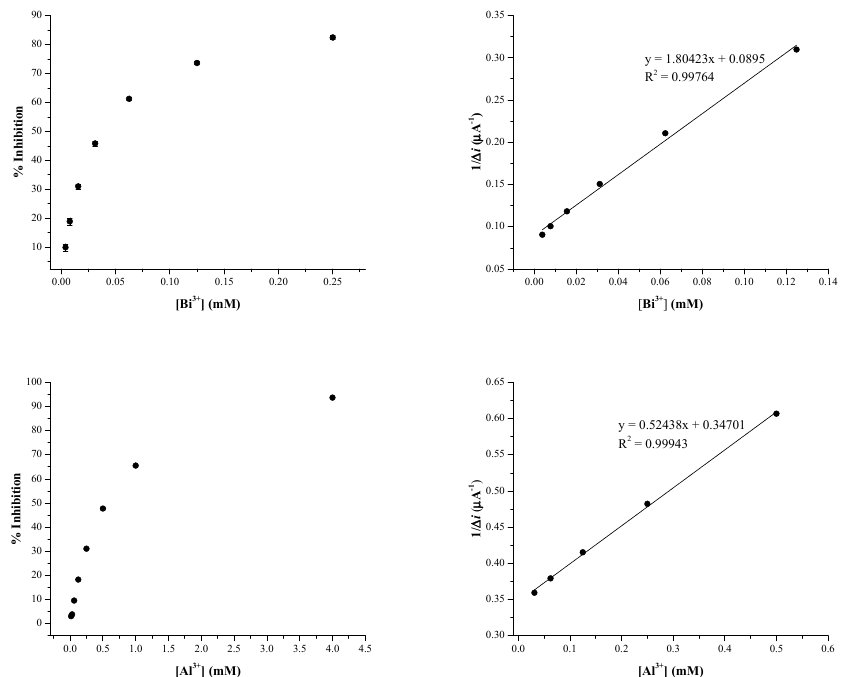
Figure 3. Inhibitive effects and Dixon plot for Pt/PPD/GOx biosensor after the injection of different concentration of Bi 3+ and Al 3+ ions in presence of 20 mM of glucose.